Question: Produce a descriptive caption suitable for publication.
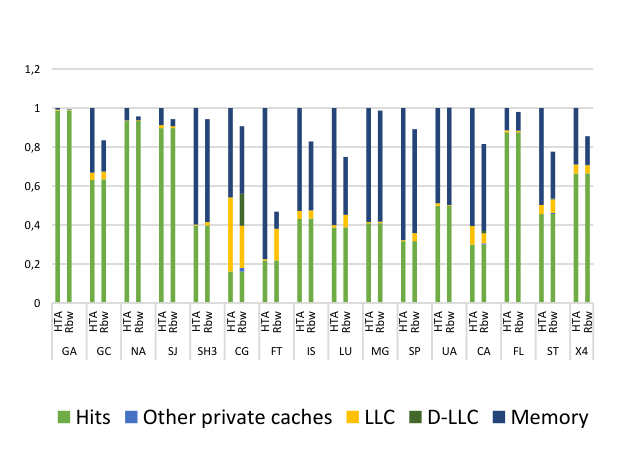
Answer: HTA-normalized average memory access latency for  Rainbow in a 2-CMP system for 16k entries.